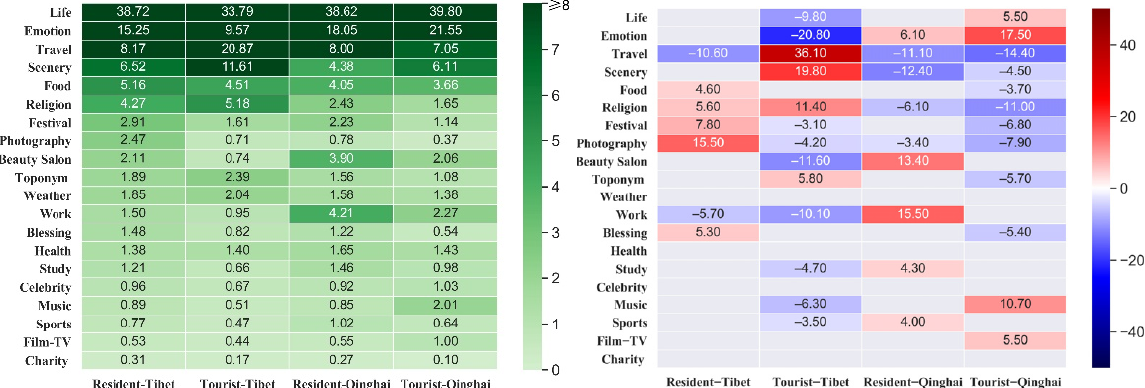
Figure 3. Distribution and adjusted standardized Chi-square residuals for the top 20 topics in the four datasets (unit: %).